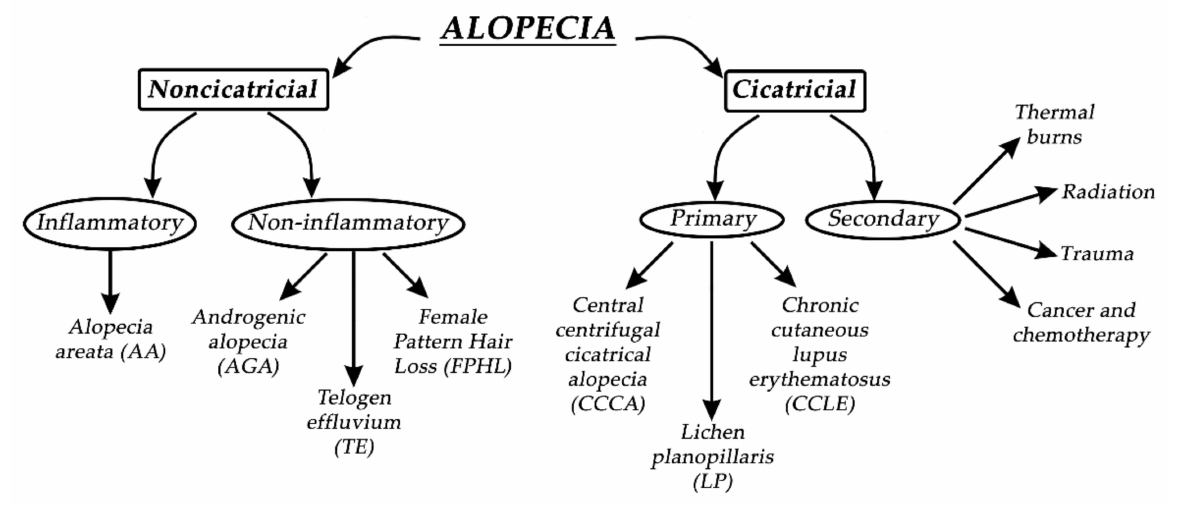
Figure 3. Types of